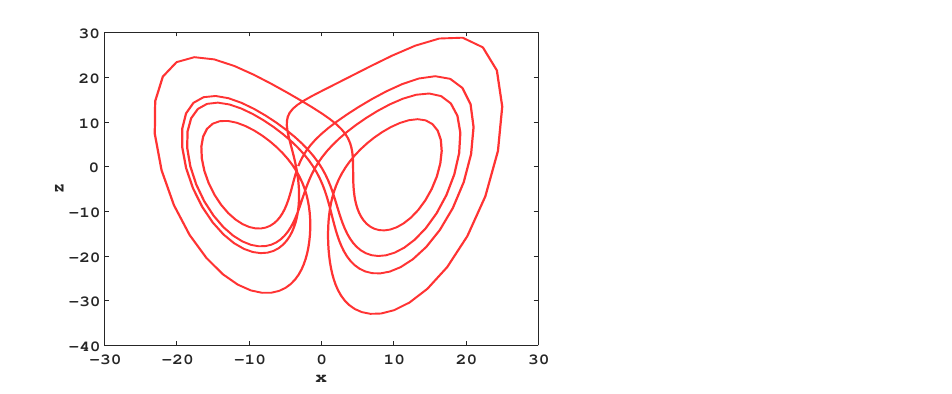
Figure 17. Cycle 02130101 with topological length 8 in system (2) for parameters ( a , b , c , k , m ) = ( 10,100,2.7, − 0.2,1 ) . Table 2. Eighteen unstable periodic orbits embedded in the hidden hyperchaotic attractor of system (2) for ( a , b , c , k , m ) = ( 10,100,2.7, − 0.2,1 ) ; listed are the topological length, itinerary p , period T p , and four coordinates of a point on the